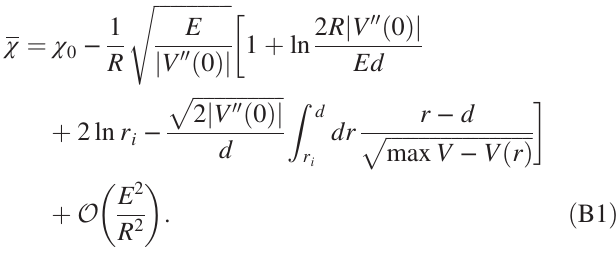
p ffiffiffiffiffiffiffiffiffiffiffiffiffiffiffiffiffi 2 j V 00 ð 0 Þj